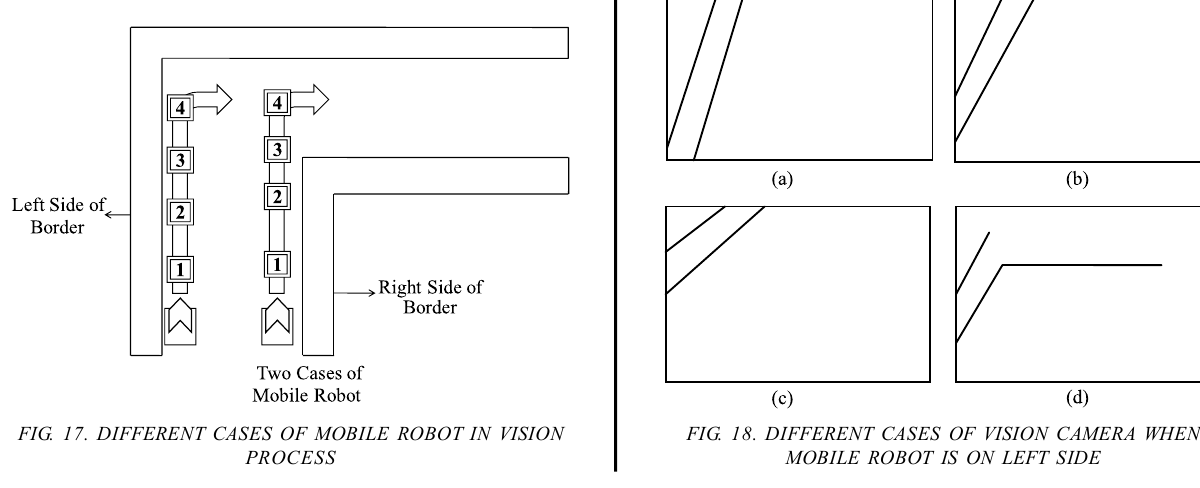
FIG. 17. DIFFERENT CASES OF MOBILE ROBOT IN VISION PROCESS